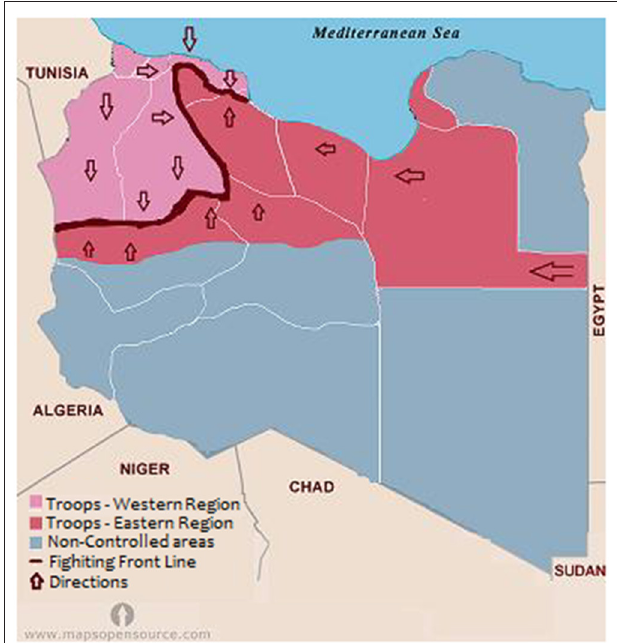
FIGURE 1 | Map of Libya showing the geographic areas controlled by each fighting group during the emergence of COVID-19 in 2020.